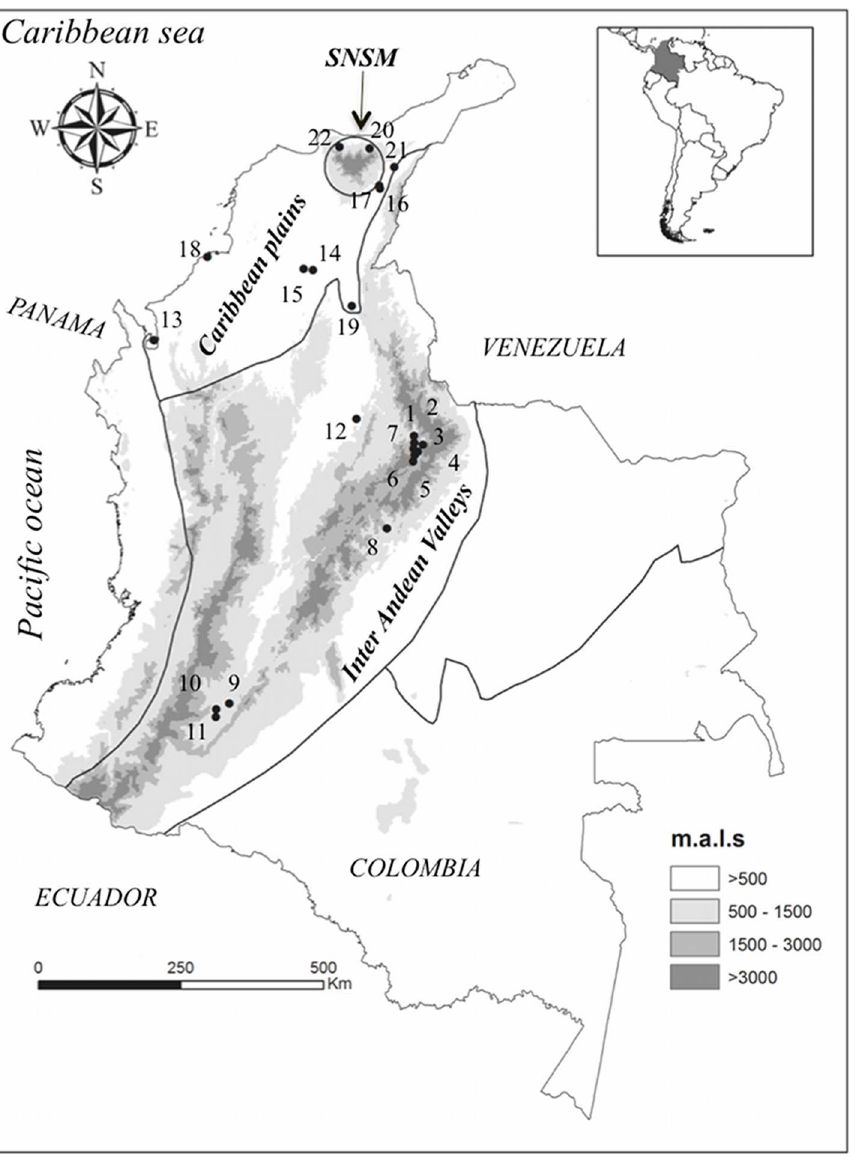
Figure 1. Geographical distribution of the sampling sites of the Colombian T.dimidiata populations studied. Map of Colombia showing the 22 T. dimidiata sampling sites used in differentiation and demographic analyses. Site numbers are detailed in Table 1. Eco-geographical regions correspond to the Inter-Andean Valleys region, the Caribbean Plains region, and the Sierra Nevada de Santa Marta Mountain.